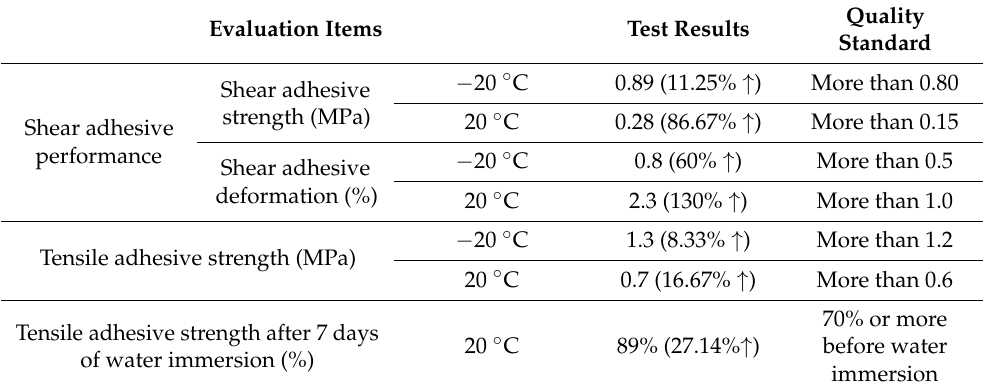
Table 8. Performance test results of waterproofing sheet effect on APC pavement layer.